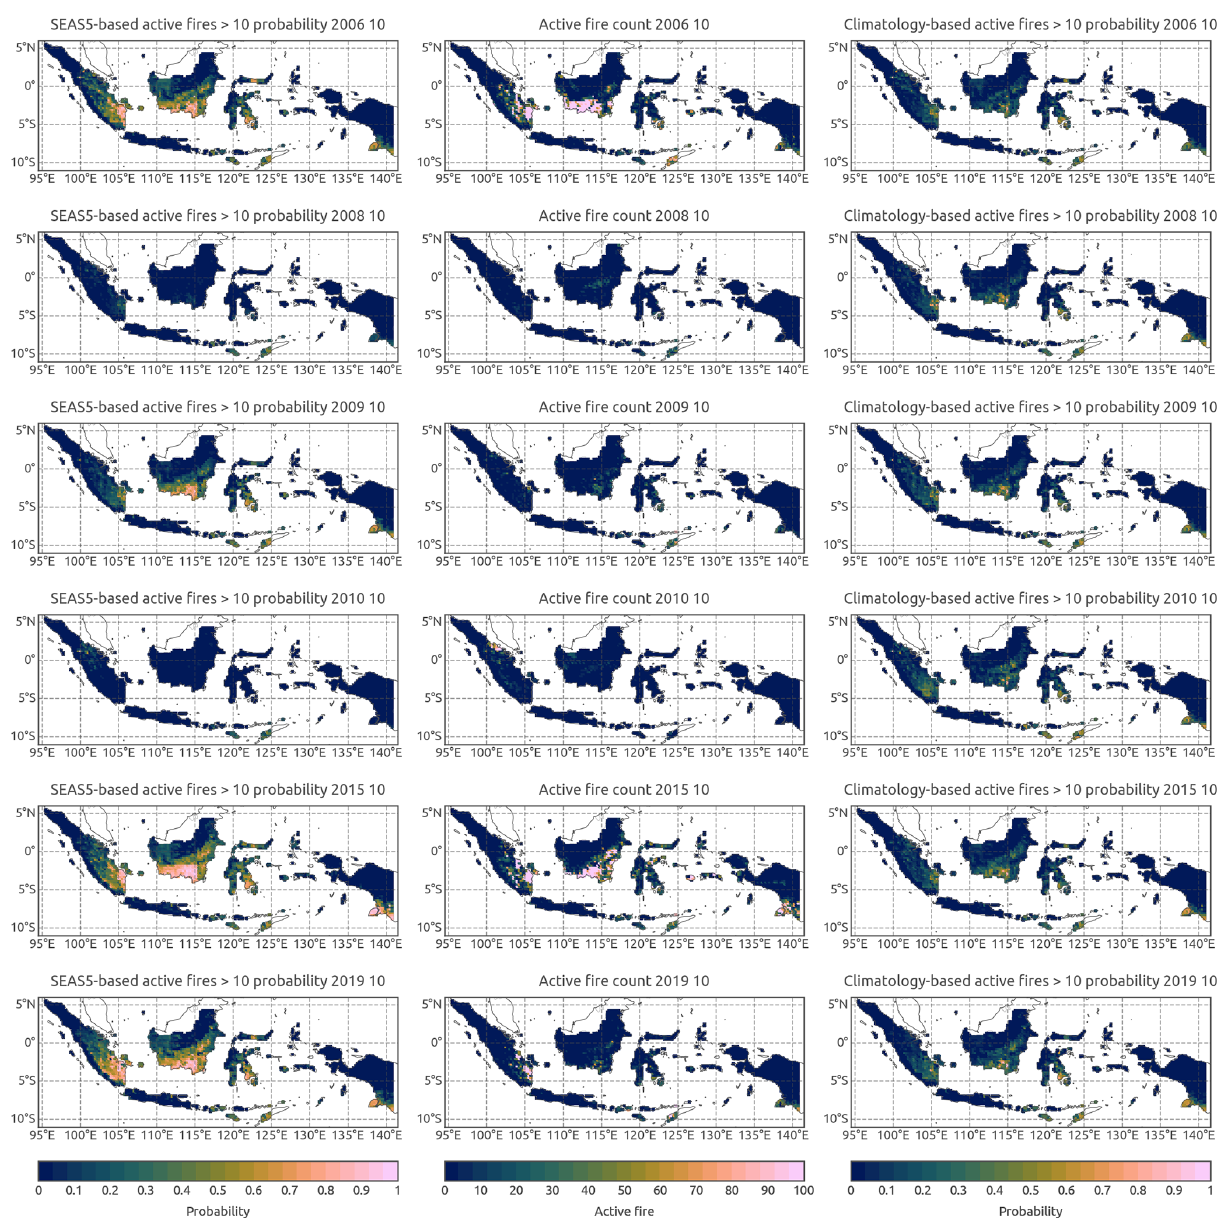
Figure 6. Model prediction of probability of an active-fire count of > 10 cases and observed active-fire counts. Shown are SEAS5-based (left column) and climatology-based (right column) probability predictions at lead time of 2 months and observed monthly active-fire counts (middle row) for October in 6 example years (rows). Please note that the date format used in this figure is year